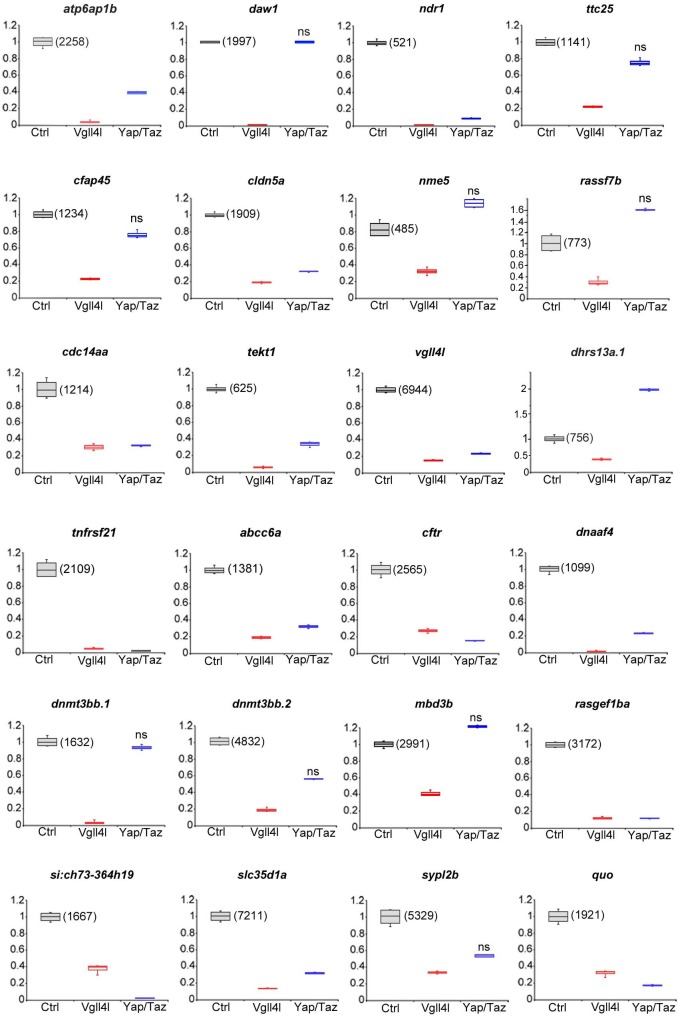
Differential expression at late gastrulation of the genes analyzed by in situ hybridization in Vgll4l depleted embryos.Box plots of the expression of the genes presented in Figure 4 in Control embryos (Ctrl - gray), in Vgll4 (red) and in Yap/Taz (blue) loss-of-function conditions. Gene expression in control samples was normalized to one and the amount of transcripts (expressed as normalized counts) is indicated for the control. For Vgll4l loss of function the 24 genes analyzed are differentially expressed (|log2FoldChange| > 1, adjusted p-value<0.05). This is also the case for Yap/Taz loss-of-function except when mentioned otherwise: ns (not significant). Numerical data and adjusted p-value for all conditions are available is Supplementary file 1. Adjusted p-value is <0.0001 for all differentially downregulated genes in Vgll4l or Yap/Taz loss-of-function conditions. The box in box-plots indicates the first and third quantile and the black horizontal bar within the box illustrates the median (or second quantile). The ends of the whiskers are set at 1.5*Interquartile range (IQR) above the third quartile (Q3) and 1.5*IQR below the first quartile (Q1).